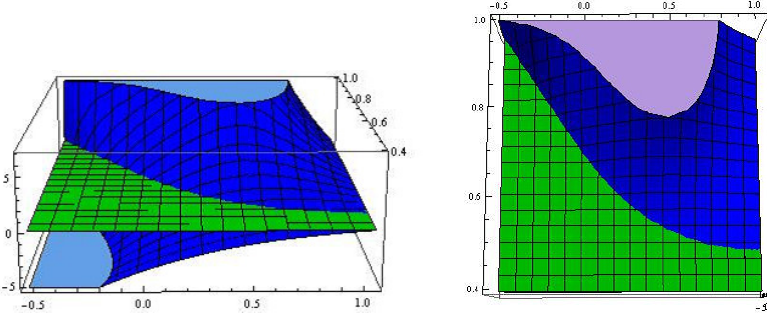
Figure 1. The locus of ( φ , s ) which satisfies (3) (the intersection curve of the green domain and the blue